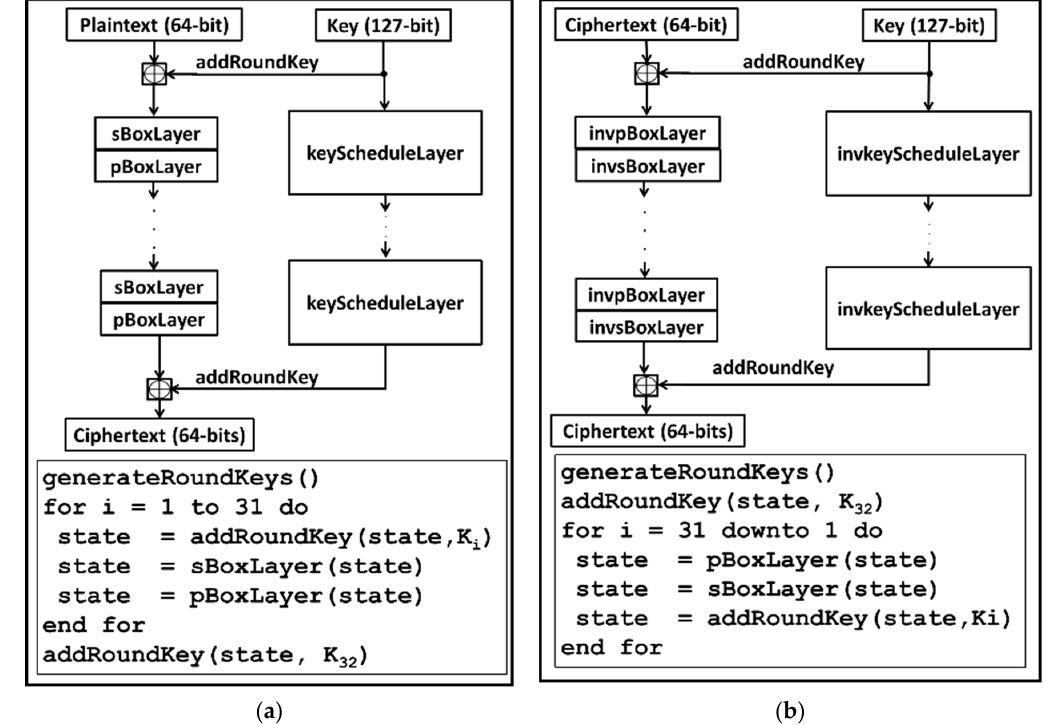
Figure 4. Top level description of PRESENT algorithm: ( a ) PRESENT encryption routine; ( b ) PRESENT decryption routine.